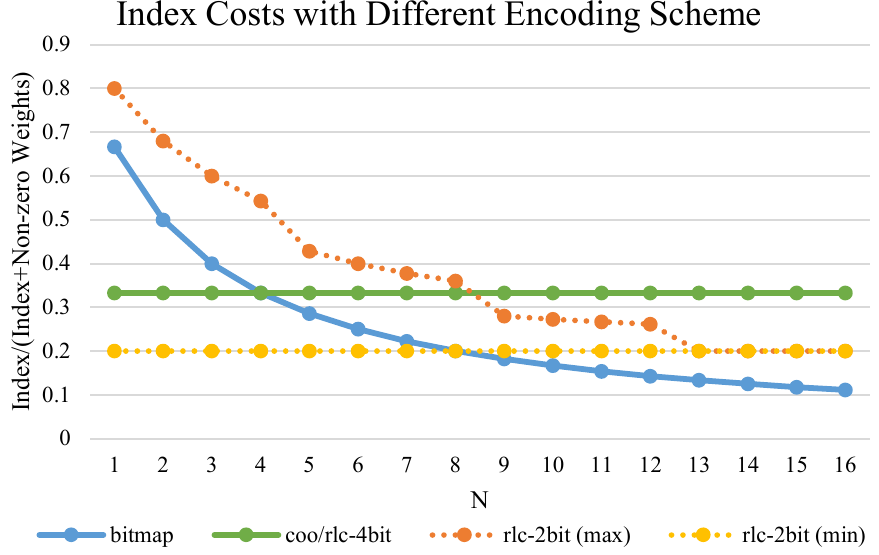
Figure 6. Comparison of different encoding schemes with M = 16. For RLC, the ‘run length’ is 4 (2 bits), and the compact and loose distribution of zeros are shown as ‘min’ and ‘max,’